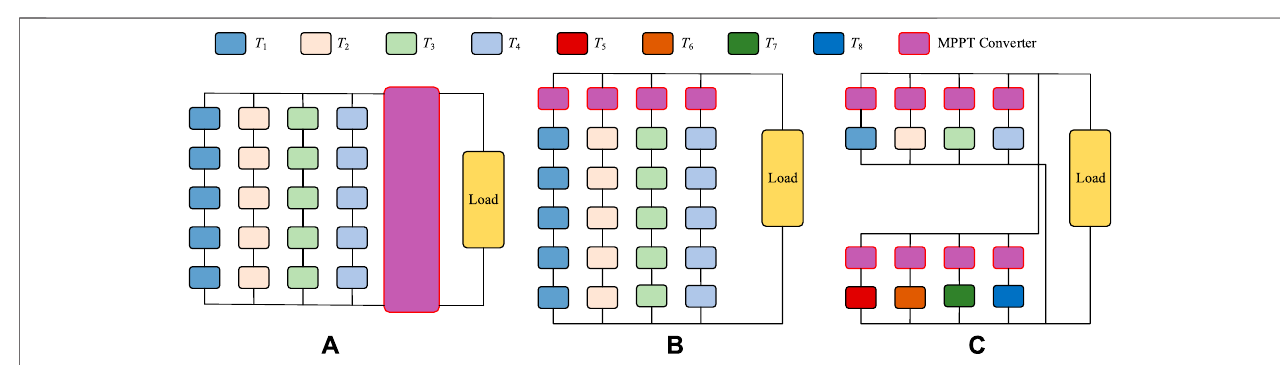
Frontiers in Energy Research |